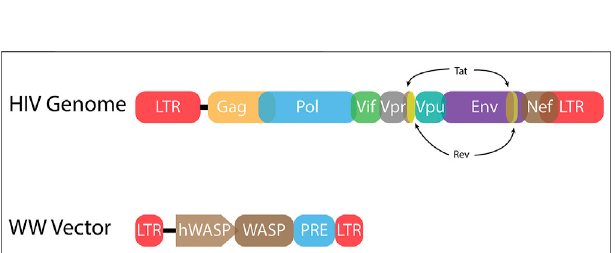
FIGURE 2 | Timeline of developments in retroviral gene therapy vectors and targeted integration.